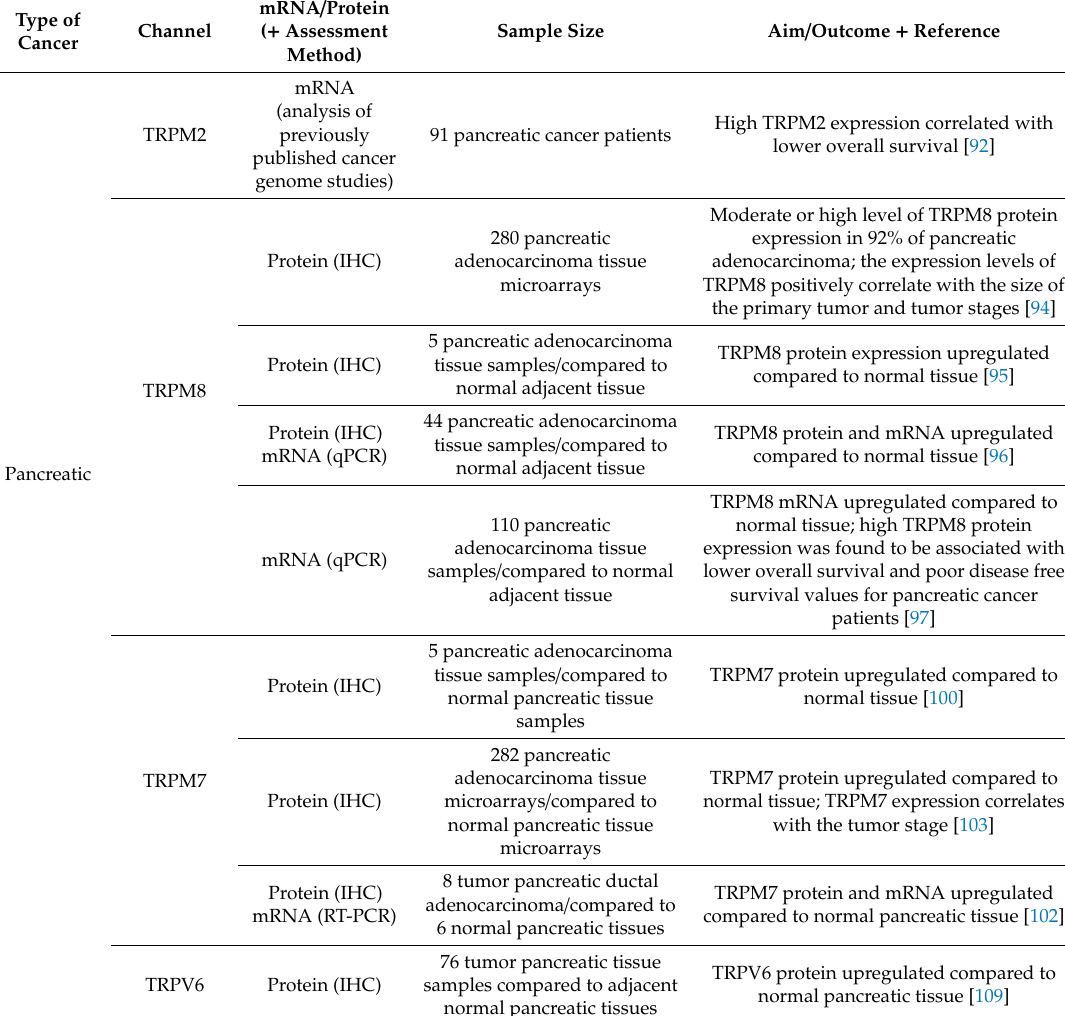
Table 4. Expression of TRP channels in human pancreatic cancer